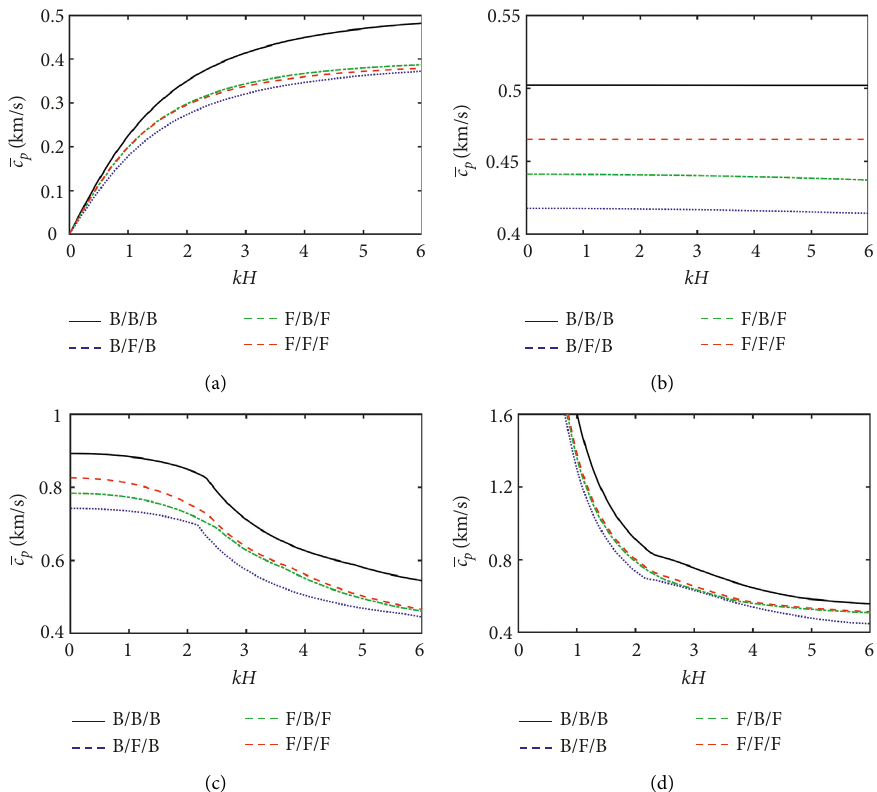
Figure 4: Dispersion curves of guided waves in the three-layered plates with different stacking sequences for (a) the first mode, (b) the second mode, (c) the third mode, and (d) the fourth